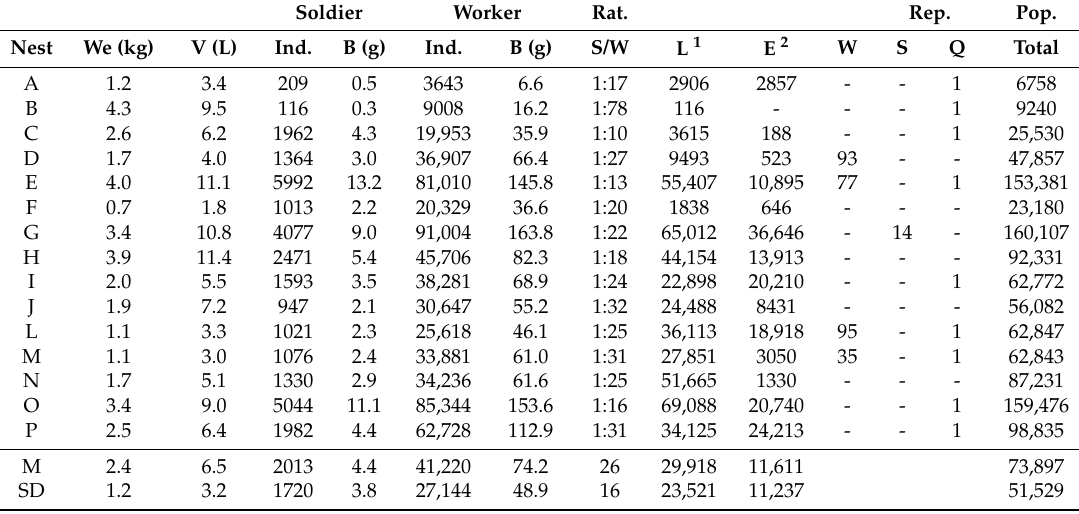
Table 1. Composition of 15 nests of Microcertotermes indistinctus analyzed in an area of Caatinga